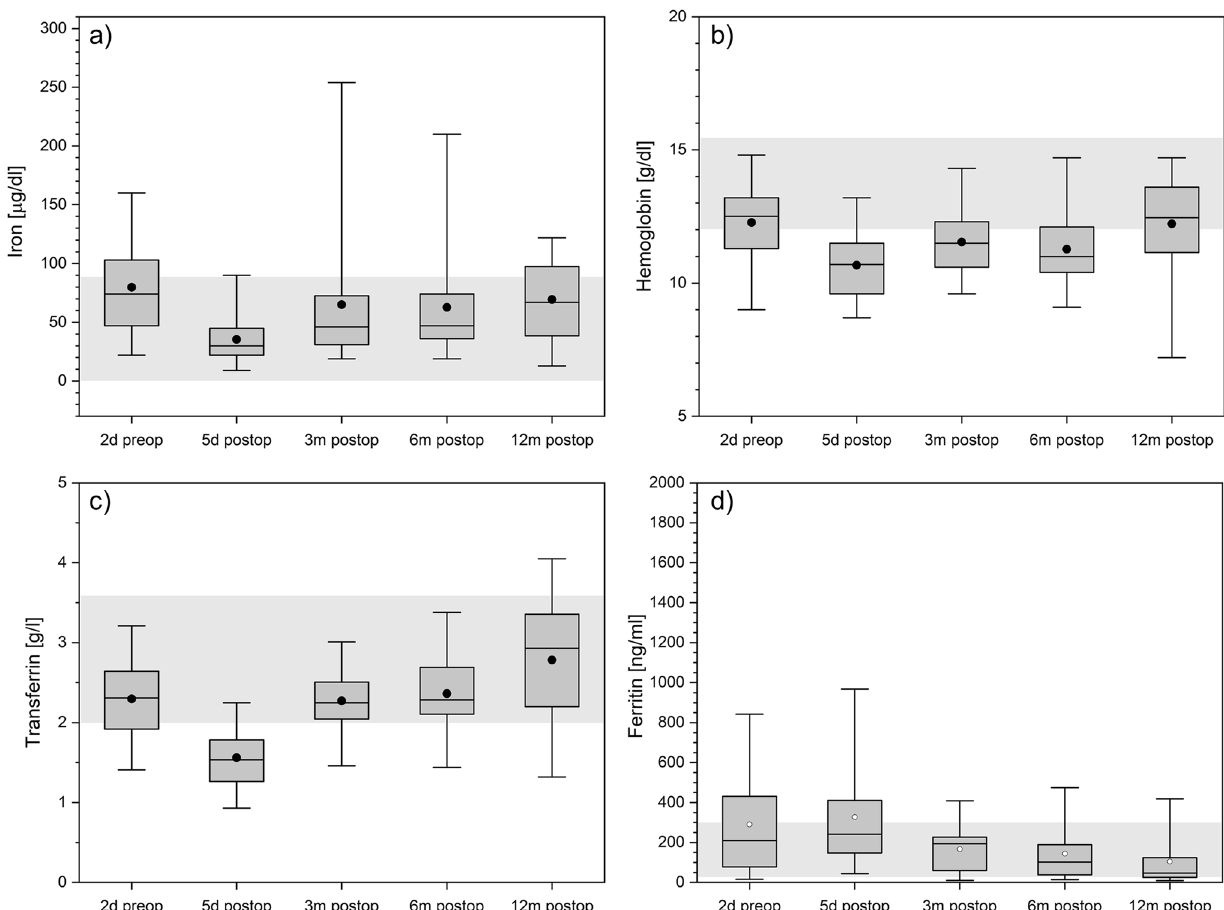
Figure 5. Iron (panel a ), hemoglobin (panel b ), transferrin (panel c ), and ferritin (panel d ) over time. The boxes contain the 25% and the 75% quartile as well as the median, black dots depict the mean, and whiskers range from the 5% percentile to the 95% percentile. Gray areas depict the normal range for each